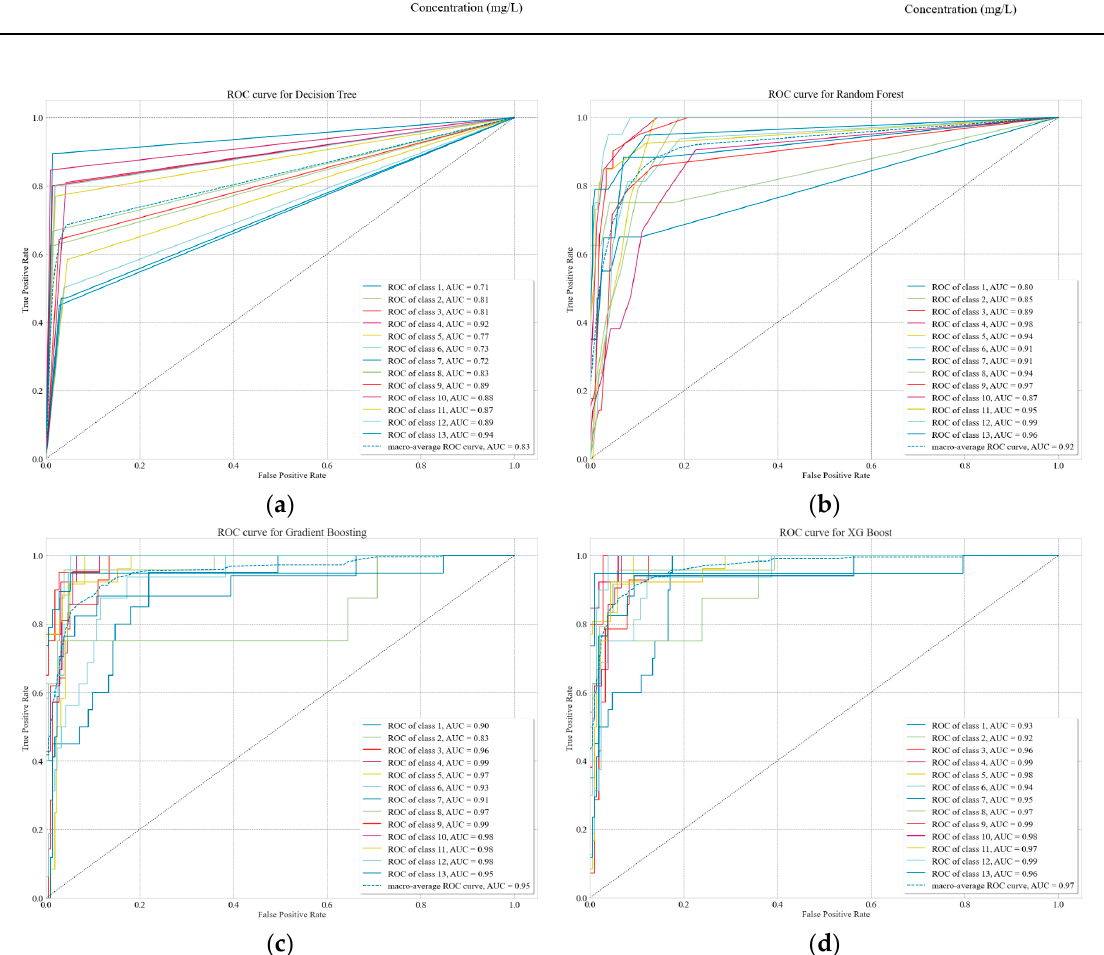
Figure A1. Accuracy evaluation for each machine learning algorithm using receiver operating characteristic curve and area under the curve . ( a ) ROC curve and AUC result of Decision Tree, ( b ) ROC curve and AUC result of Random Forest, ( c ) ROC curve and AUC result of Gradient Boosting, and ( d ) ROC curve and AUC result of XG Boost.